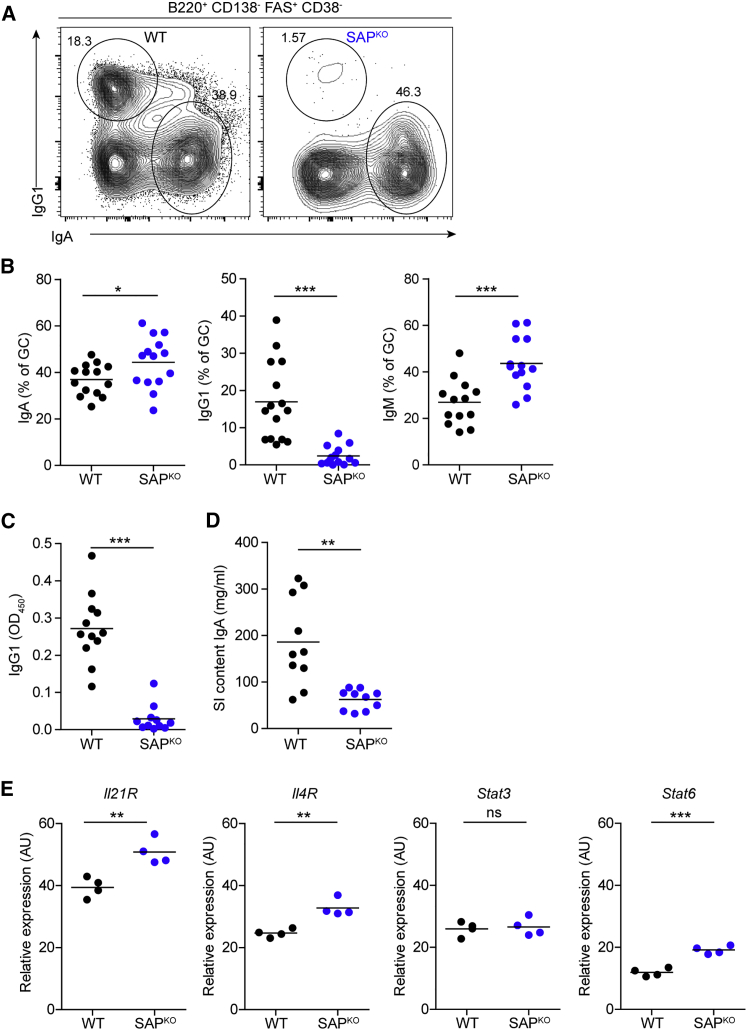
SAP-Mediated T Cell Help Is Not Required for Generation of IgA+ GC B Cells in PPs(A) Representative flow cytometry plots showing IgG1 and IgA isotype frequency gated from GC B cells derived from WT or SAP-deficient mice.(B) Quantification of GC isotype frequencies, as shown in (A). Data are pooled from four independent experiments; each dot represents a single mouse; line represents the mean.(C) Levels of IgG1 in the sera of WT and SAPKO mice as estimated by standard ELISA.(D) Quantification of IgA antibodies in the intestinal contents of WT and SAPKO mice as measured by ELISA.(E) qPCR for IL21R, IL4R, STAT3, and STAT6 transcripts in sorted GC B cells (GL7+ FAS+) derived from PPs of WT and SAPKO mice.Data are pooled from two independent experiments with two mice in each experiment. Each dot represents a single mouse, line represents the mean. ∗p < 0.05, ∗∗p < 0.01, ∗∗∗p < 0.0001, two-tailed Student’s t test. ns, not significant.